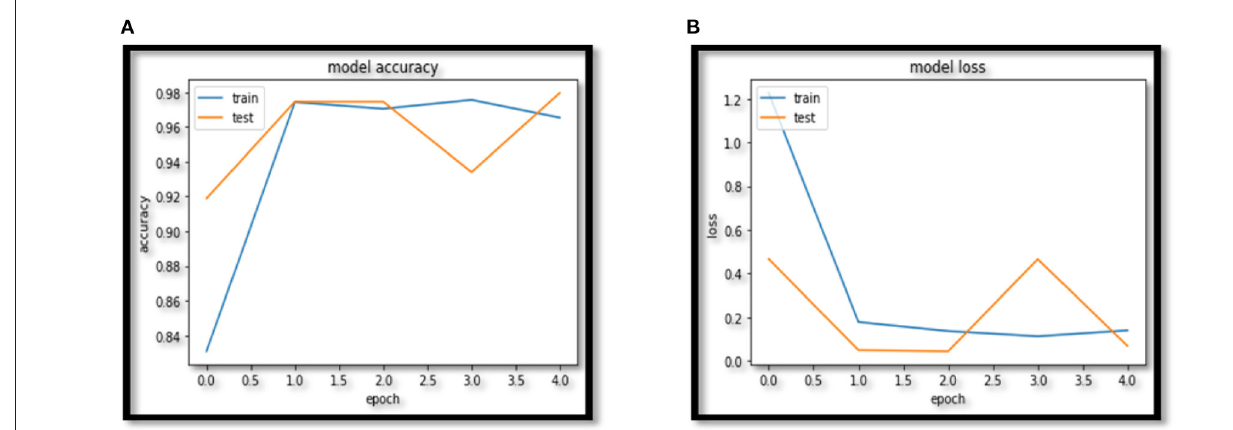
FIGURE 9 | (A) Xception accuracy. (B) Xception loss.